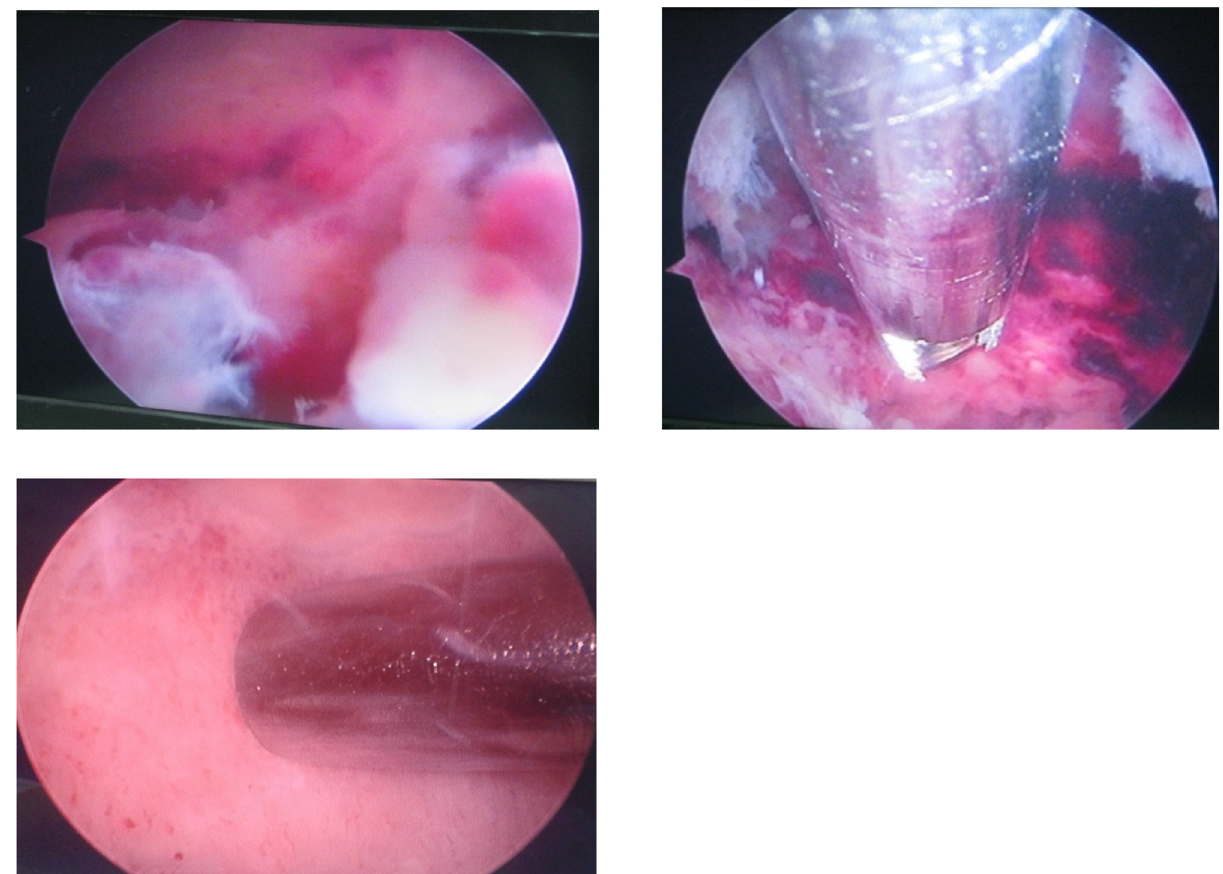
Figure 1. Serial pictures of endoscopic curettage procedure of an ABC (case 7) showing: fi rst pic (top left) the lesion from inside after accessing it through its bony cortex with a trocar. Another portal was created to introduce a 3.5 blade of a motorized shaver followed by a blunt curette (top right). The curettage procedure ends when a healthy bony walls of the lesion (bottom) is clearly visualized from all angles.